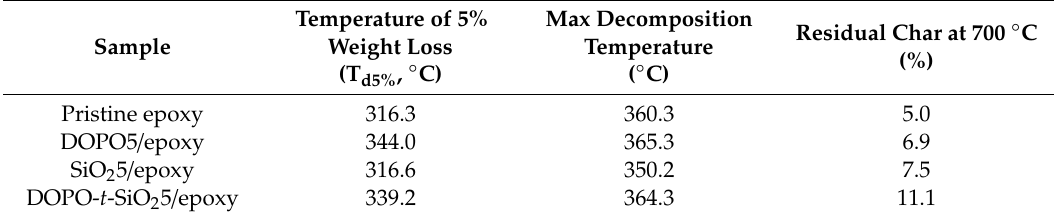
Figure S1. SEM and EDS spectrum of (a) GPTMS- t -SiO 2 NPs and (b) DOPO- t -SiO 2 NPs,